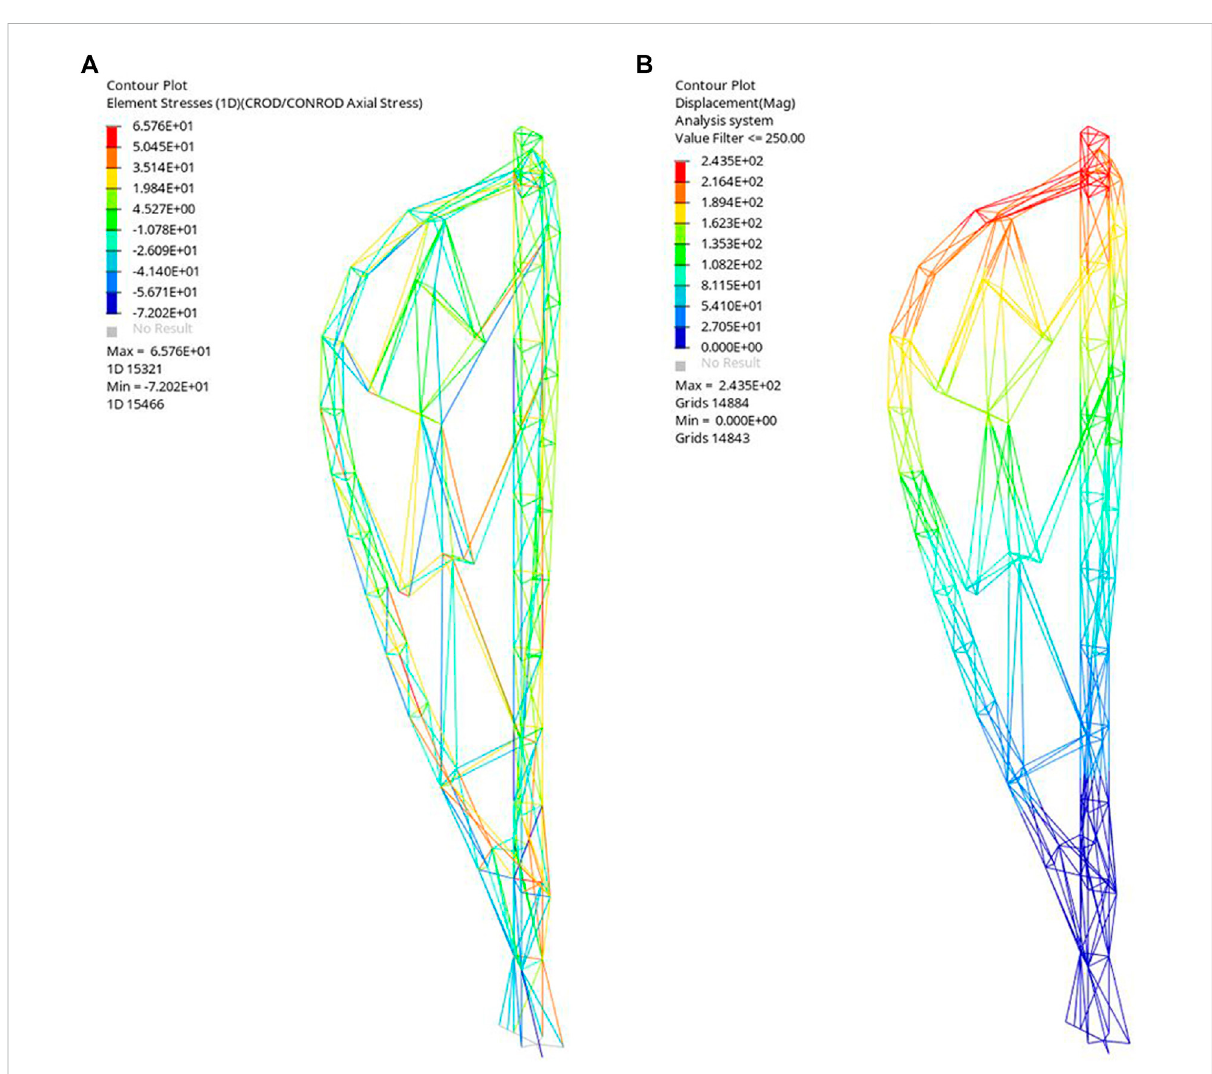
FIGURE 11 The displacement (A) and stress results (B) for the LC#2 applied to the fi nal con fi guration (IT3 of Figure